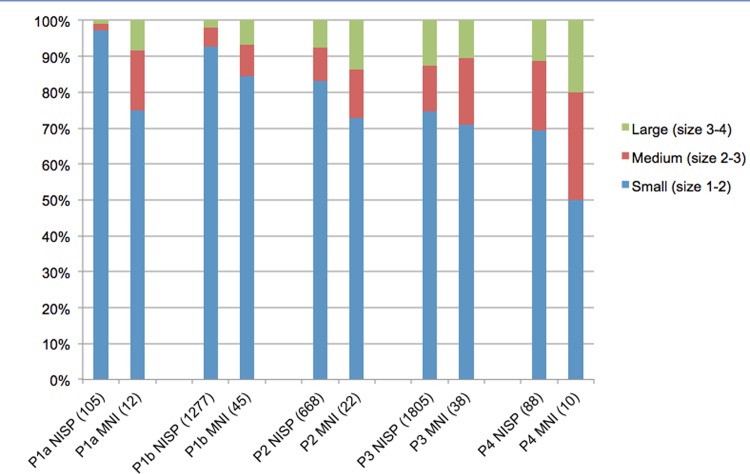
Decline in large mammals in Kuumbi Cave Trench 10.Diachronic trends in nonhuman mammalian carcass sizes (see Methods), excluding mammals smaller than Size 1 (e.g., rodents, bats, hyrax, mongoose, galago). Some of the medium and large animals in Phase 1 are cattle- and caprine-sized bovids but could not be identified to taxon, and might be either domestic or extirpated taxa. NISP, number of identified specimens; MNI, minimum number of individuals.